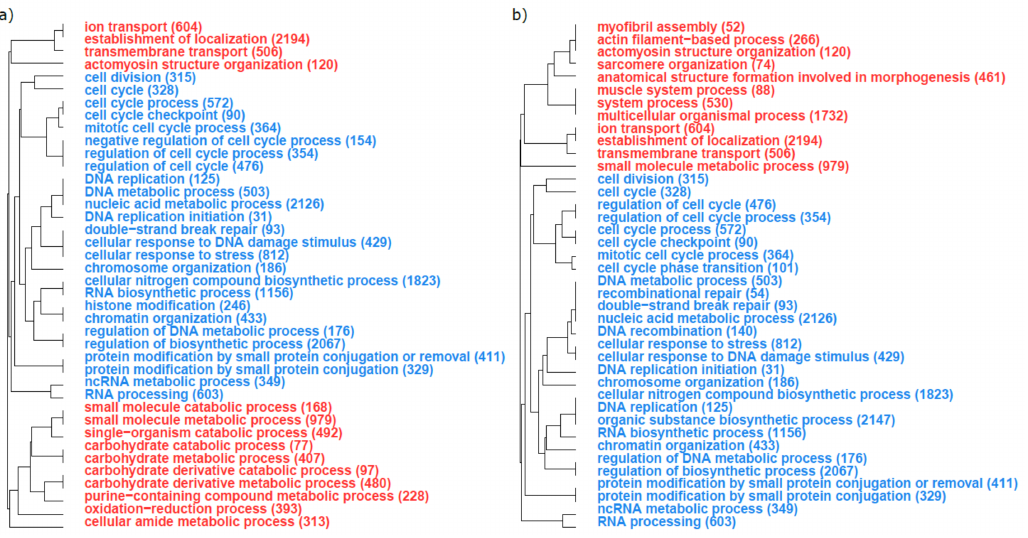
Figure 3. Top 40 of the gene ontologies (GOs) that were the most enriched in differentially expressed genes in the comparison between ( a ) parasites infecting minnow and dace and ( b ) parasites infecting gudgeon and dace. Blue GOs are enriched in genes that are under-expressed when comparing parasites sampled on alternative host parasites to those sampled on the principal host species. Red GOs are enriched in genes that are over-expressed when comparing parasites sampled on alternative host parasites to those sampled on the principal host species. The total number of genes involved in each GO is given in